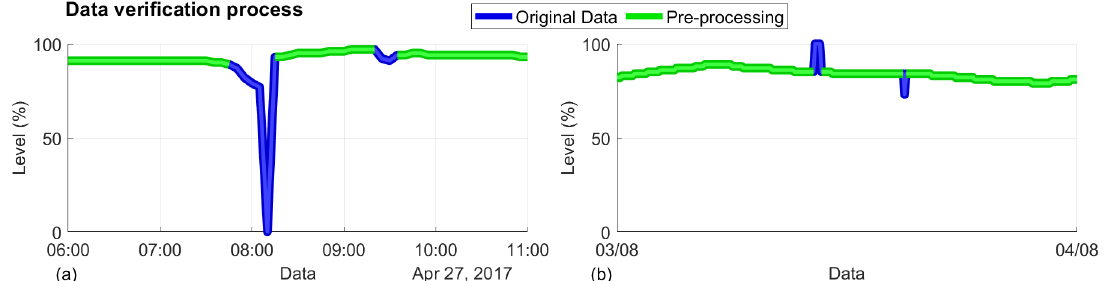
Figure 2. Particular cases of the signal pre-processing step: ( a ) Shows an impossible fall in the level. An operator remembers this case. It was caused by him touching the sensor accidentally. Minutes later he re-positioned the sensor, and approximately 1 h later, a technician re-calibrated the sensor. ( b ) Shows an unusual behavior of the sensor, which spontaneously read incorrect measurements of the